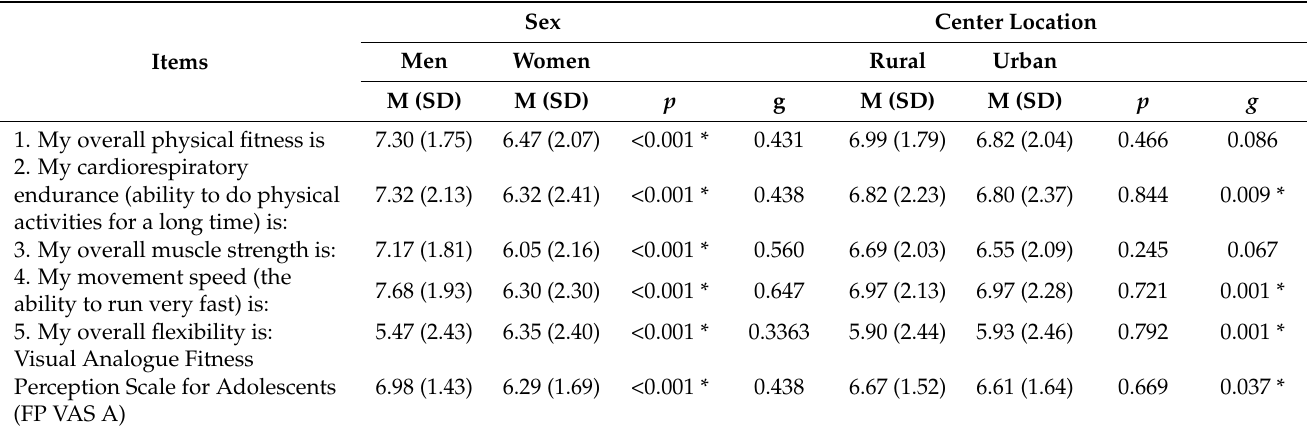
Table 2. Scores and differences obtained according to sex and center location for the items of the FP VAS A scale.